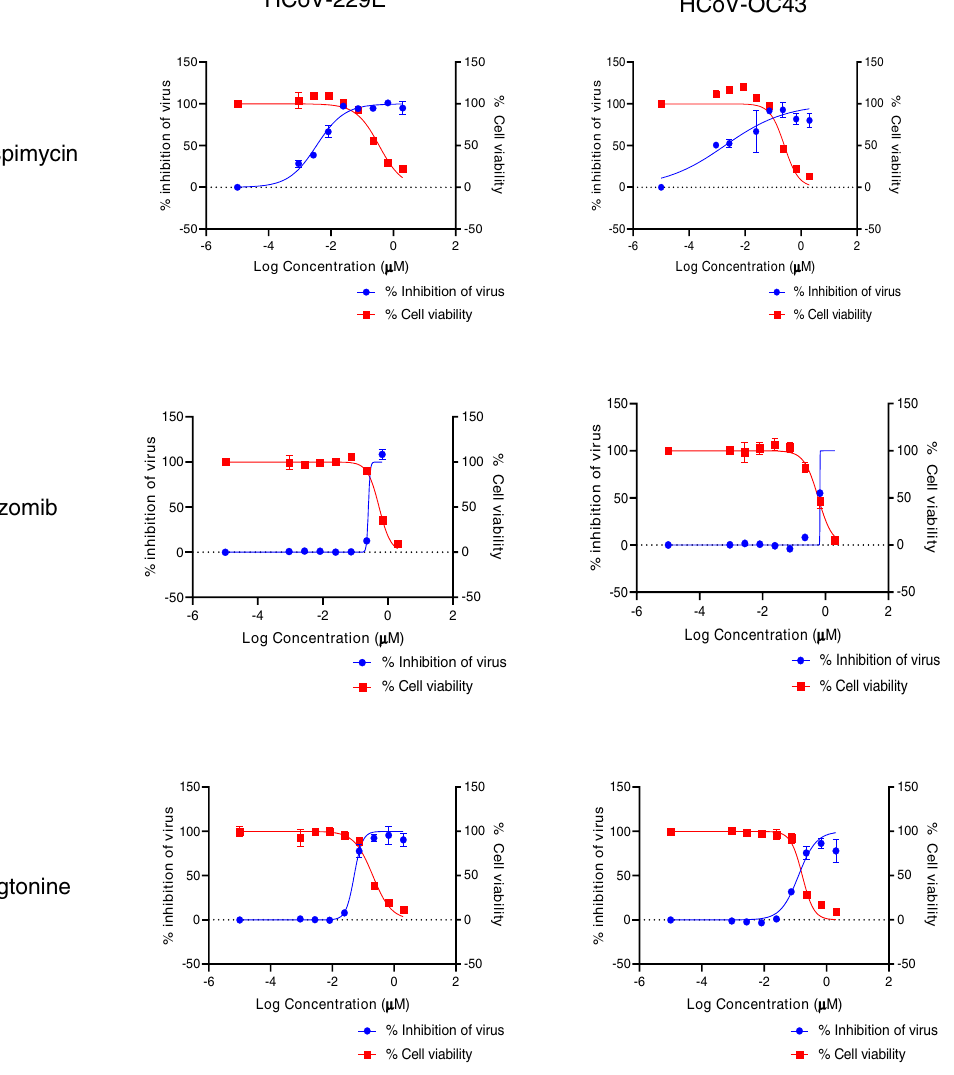
Figure 3. EC 50 versus CC 50 curves associated with Table 3 for the 3 compounds tested against HCoV-229E and HCoV-OC43 in MRC5